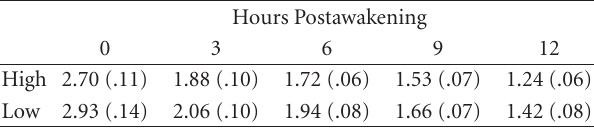
Table 4: Means (SEM) of salivary cortisol concentrations (sqrtnmol/L) in older people with high versus low scores in social network cultivation across diurnal time